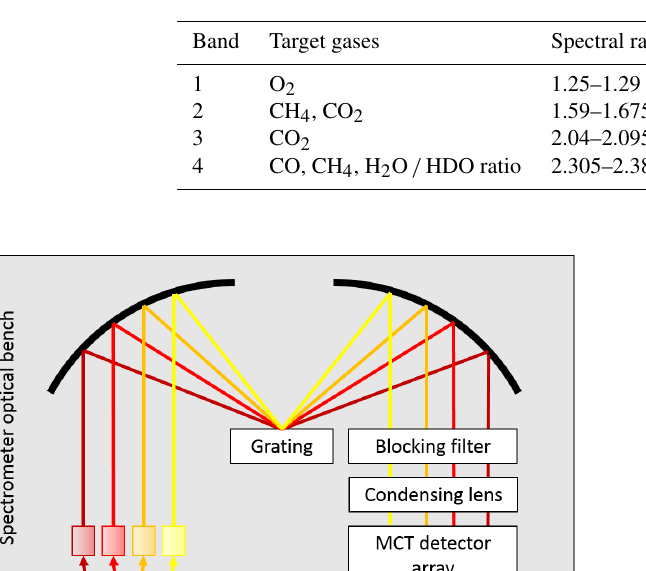
Table 1. Target gases, spectral range, spectral resolution, and signal-to-noise ratio (SNR) design requirements for each band. The goal (threshold in brackets) values are given for resolution and SNR. The SNR requirements listed here assume an integration time of 1sec.